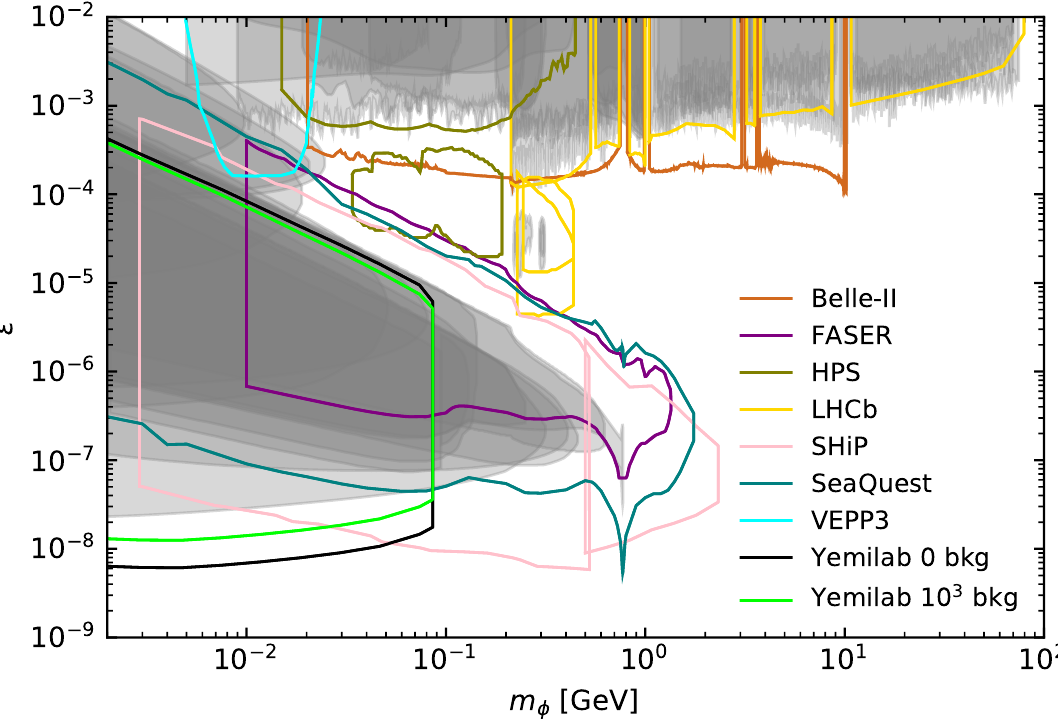
Figure 10 . Comparison of existing limits (shaded gray) and some future projections (colored lines) for DP ( m φ > 2 m e ) searches, drawn with darkcast framework [24] at https://gitlab.com/philten/ darkcast. Yemilab 95% C.L. sensitivities with zero ( 10 3 ) background events is shown in a black (green) line. Other future projections are drawn for Belle-II [45] (chocolate), FASER [25] (purple), HPS [46] (olive), LHCb [19] (gold), SHiP [44] (pink), SeaQuest [47] (teal), and VEPP3 [48]